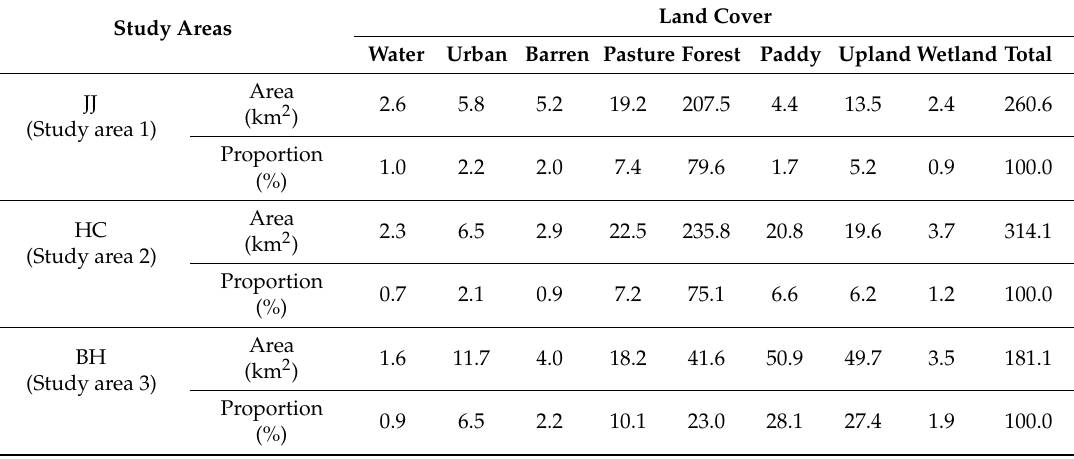
Figure 2. Land use map of the study watershed. Table 1. Summary of study areas.